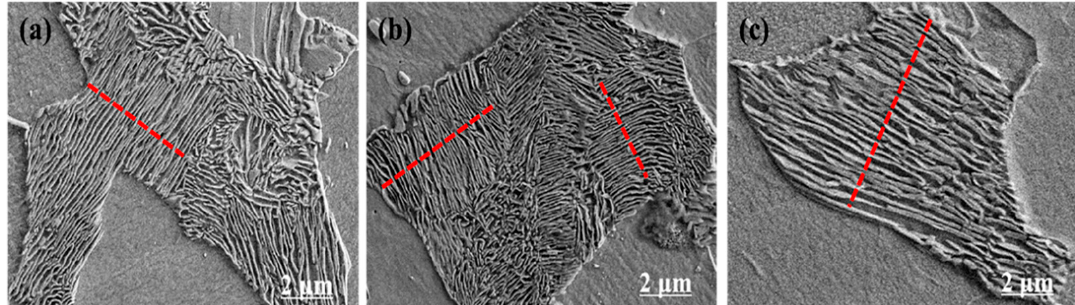
Figure 8. Pearlite lamellar morphology of the experimental steel at different final cooling temperatures after five passes. ( a ) 650 °C; ( b ) 700 °C; ( c ) 750 °C.